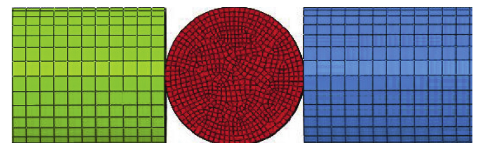
Figure 11: Dynamic split finite element model.